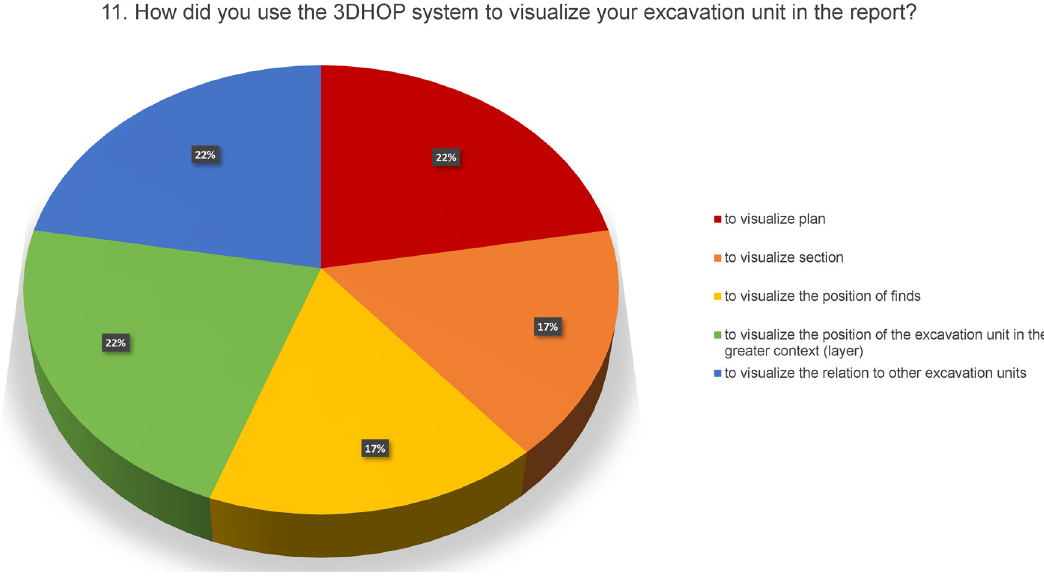
Figure 10: Question 11 represents the tools of students ’ preferences.